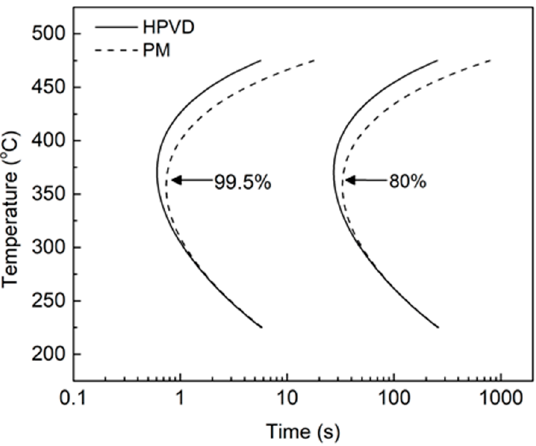
Figure 5. TTP diagrams of 99.5% and 80% of maximal hardness of HPVD (solid) and PM (dashed) castings.